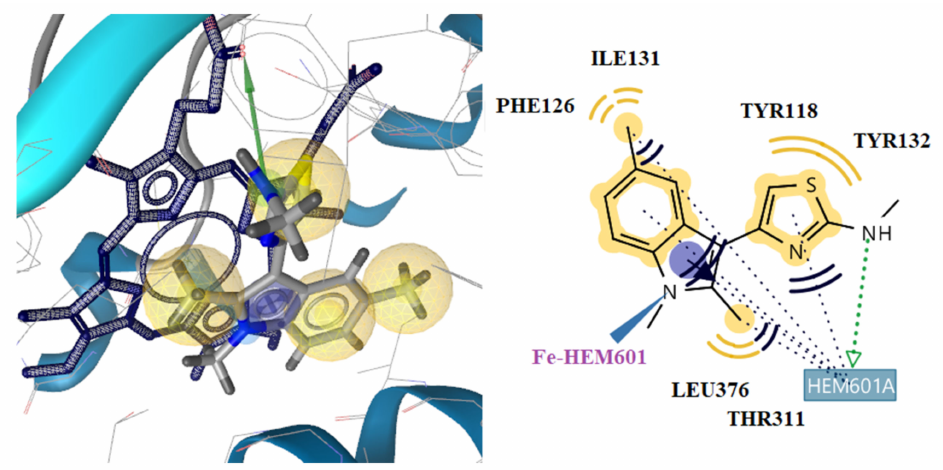
Figure 7. Docking of compound 5t to CYP51 Ca receptor. Red and green dotted arrows indicate H-bond, blue arrows aromatic interactions and yellow spheres hydrophobic